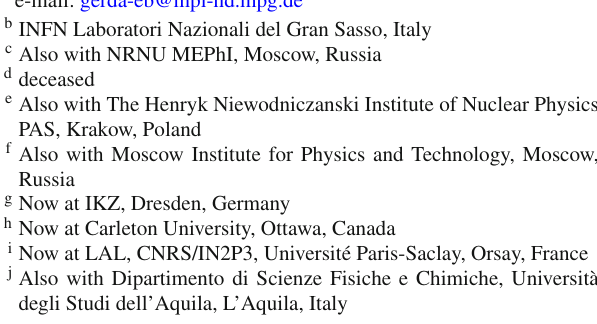
detectors was replaced in July 2012 by 5 Broad Energy Ger- manium (BEGe) detectors with a total mass of 3.6kg; these diodes served as prototypes for Phase